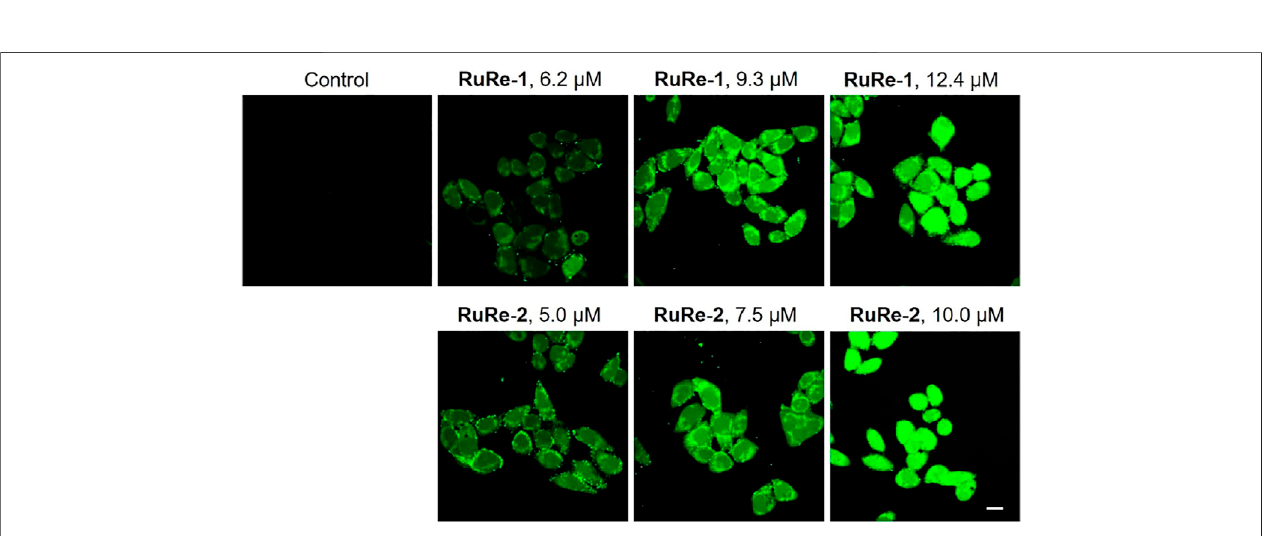
FIGURE7 |RuRe-1 and RuRe-2 induced the elevation ofintracellularROSlevels examined byconfocal microscopy withH 2 DCFDAstaining ( λ ex = 488 nm, λ em = 530 ± 20 nm). The incubation time of the compounds was 6 h. Scale bar: 20 μ m.